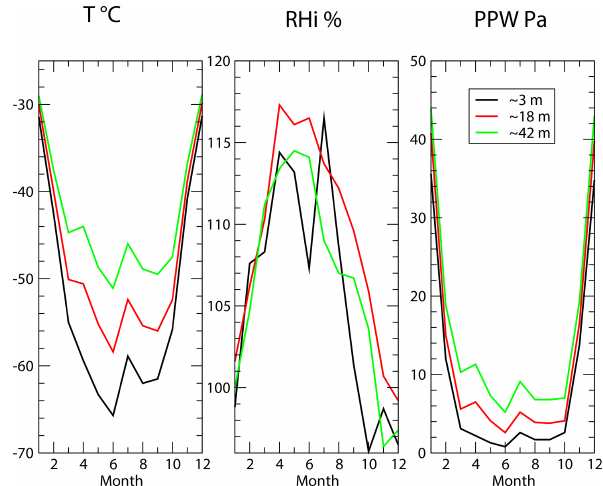
Figure 6. Mean seasonal cycle of temperature, RHi and PPW at the three levels over the period from 2018 to 2020.